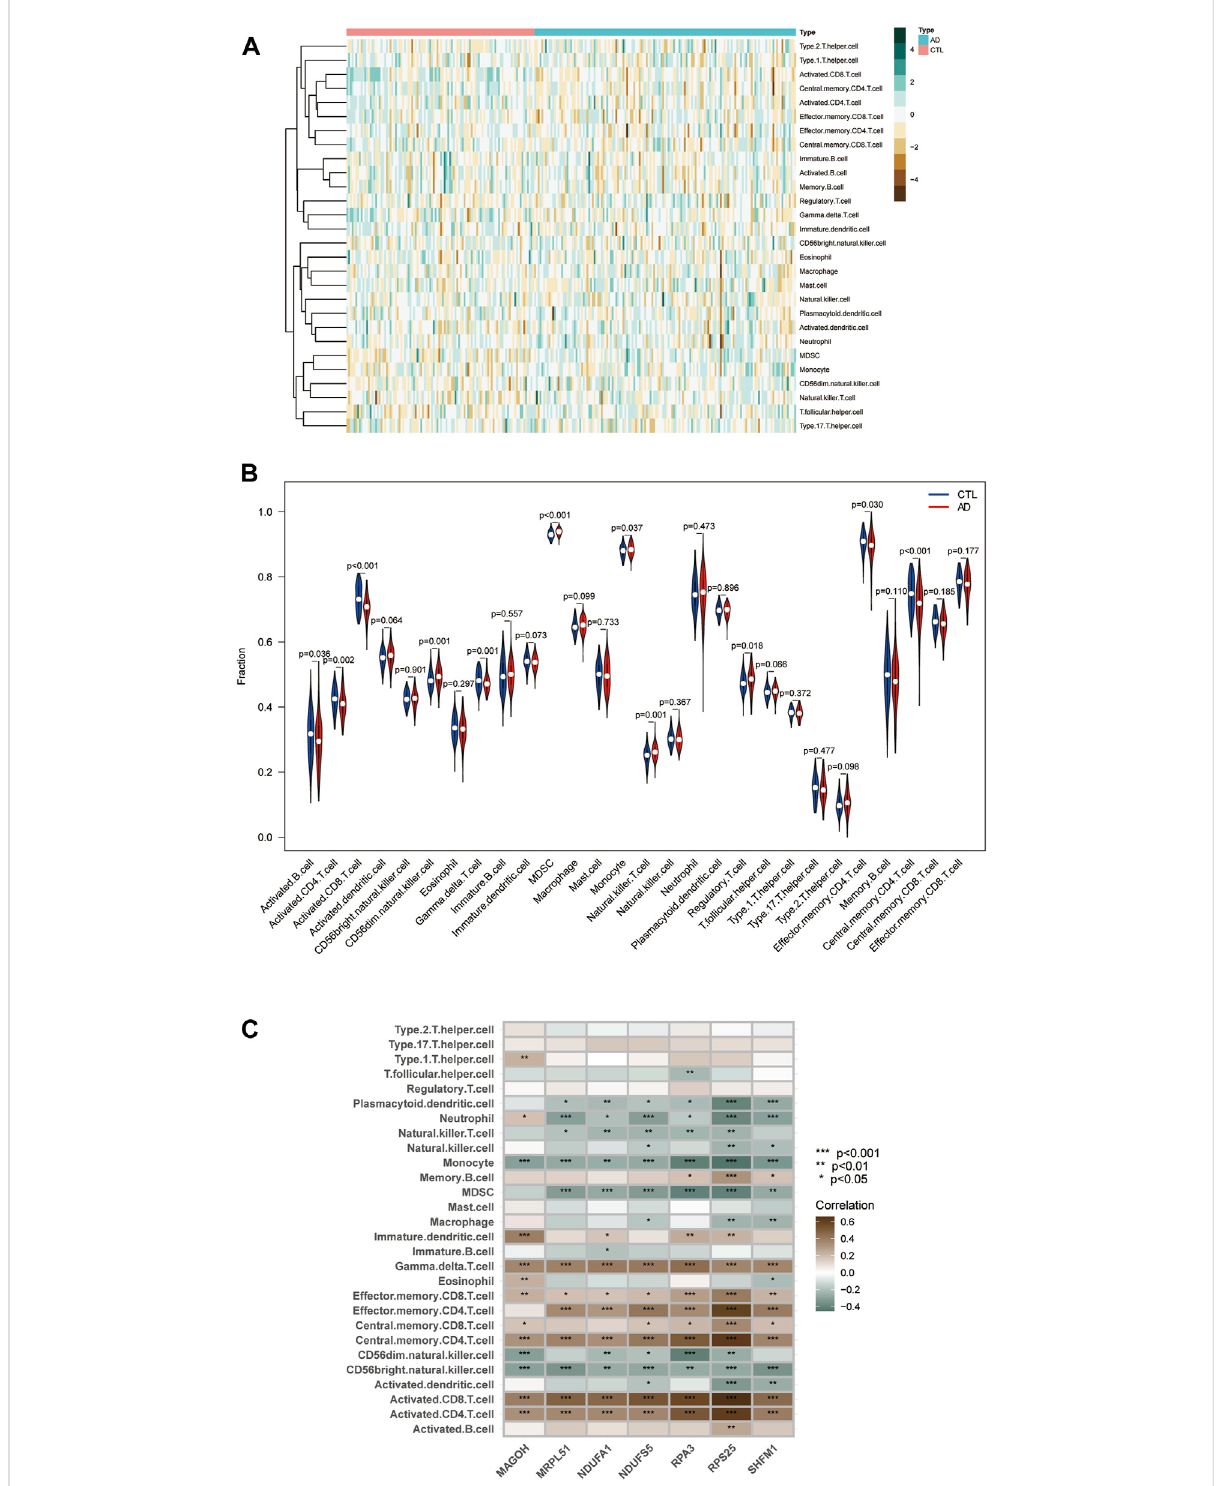
FIGURE 9 Immune in fi ltration landscape between AD and CTL obtained by ssGSEA analysis. (A) Heat map summarizing the scores of immune cell in fi ltration between AD patients and non-AD patients. (B) Violin plot showing the difference in immune cell in fi ltration between AD (red) and CTL (blue), p < 0.05, was considered statistically signi fi cant. (C) Shows the correlation between hub genes and immune cells. The colors from brown to green represent the change from positive to negative correlations, respectively. More asterisks and darker colors of the modules represent stronger